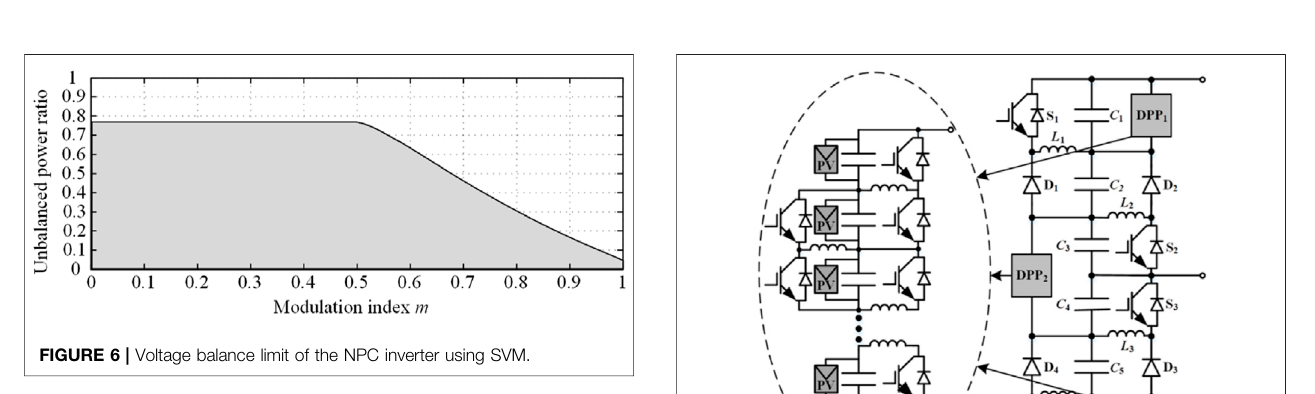
FIGURE 5 | Power fl ow diagrams of the TICC converter (A) when PV2 can compensate the power difference between PV1 and PV3 and (B) when PV2 cannot compensate the power difference between PV2 and PV3.